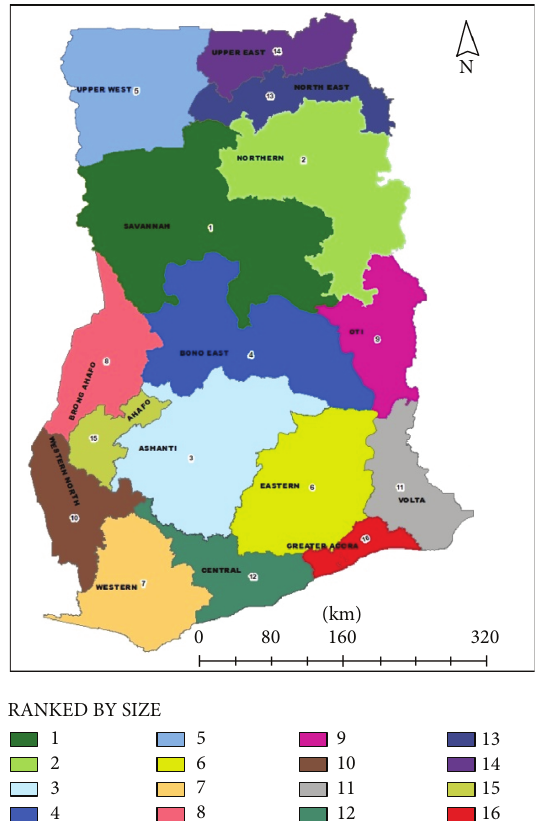
Figure 1: Map of Ghana showing all administrative regions ranked by size of land (the Ashanti Region ranked third in size of land) (source: https://upload.wikimedia.org/wikipedia/commons/e/e7/NEW_GHANA_REGIONS.jpg).